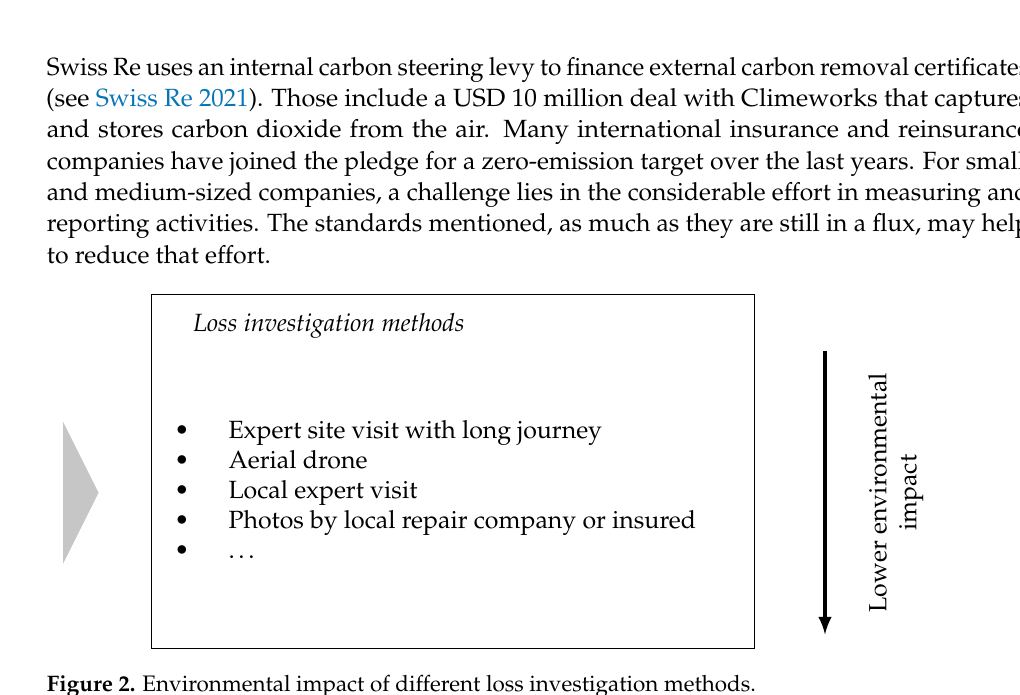
Figure 2. Environmental impact of different loss investigation